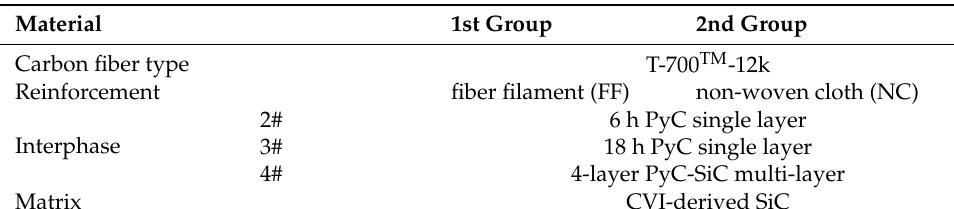
Table 1. Overall information regarding all of the samples.